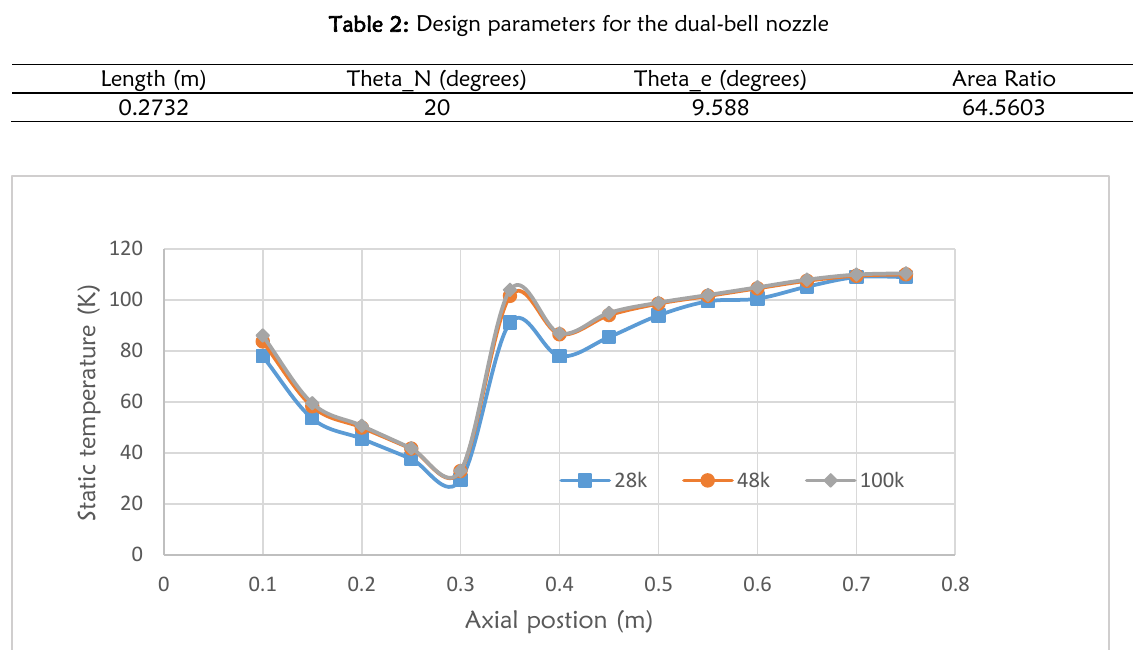
Figure 4: Grid independence test static temperature vs. axial